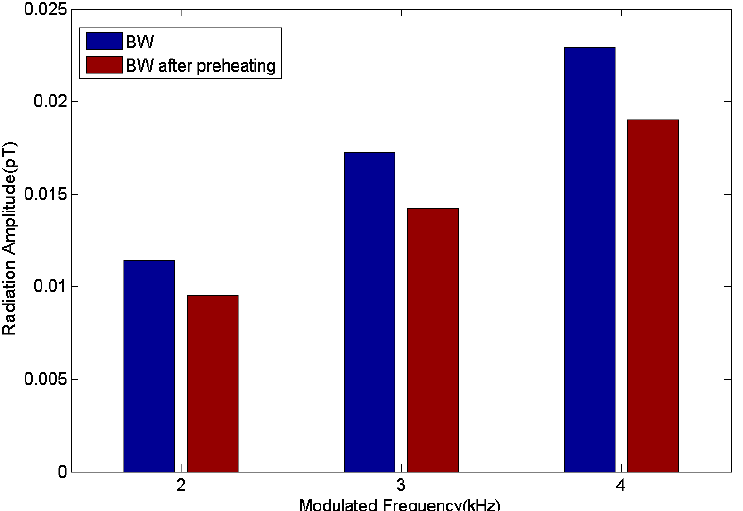
Figure 11. Simulation of signal amplitude of ELF/VLF waves generated by BW in F region with and without preheating at different modulated frequencies received at 69.737 ◦ N, 18.896 ◦ E, about 15 km east of EISCAT.